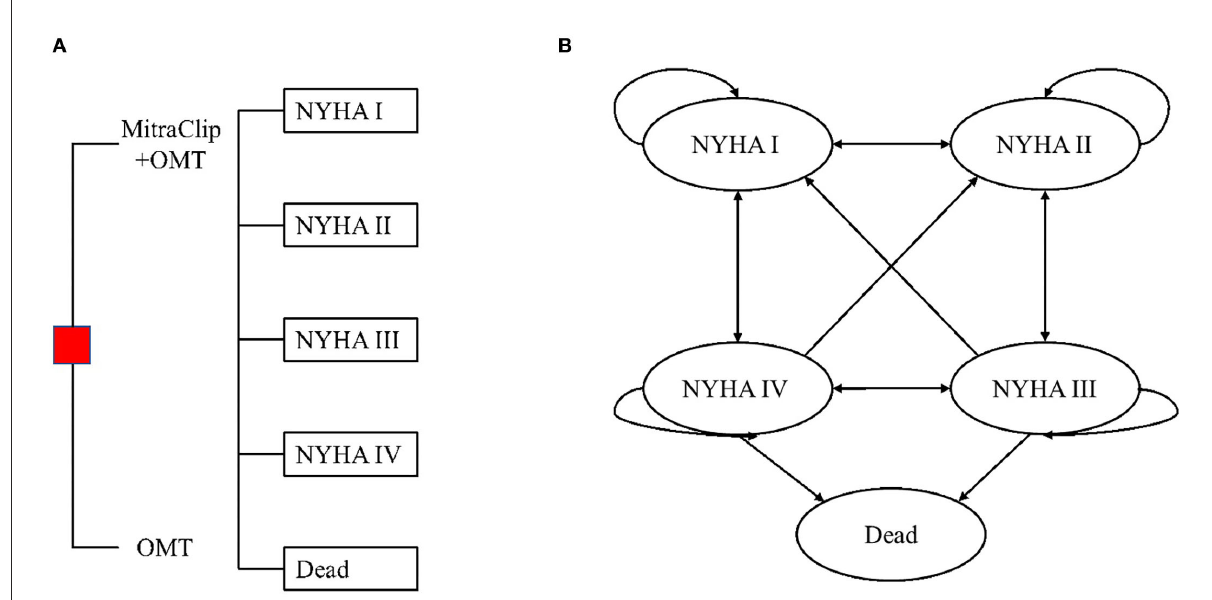
FIGURE1 (A) Decision tree and (B) state transition diagram of the Markov model. OMT, optimal medical therapy. HF patients with moderate-to-severe or severe secondary MR were randomly allocated to receive MitraClip plus OMT or OMT alone. One month after the MitraClip procedure/OMT, patients would enter the Markov model and transition among these four NYHA classifications until they entered the terminal node of the dead.